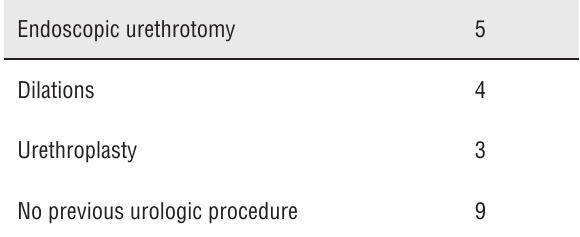
Table 3 – Complications that did not meet criteria for failure (n =